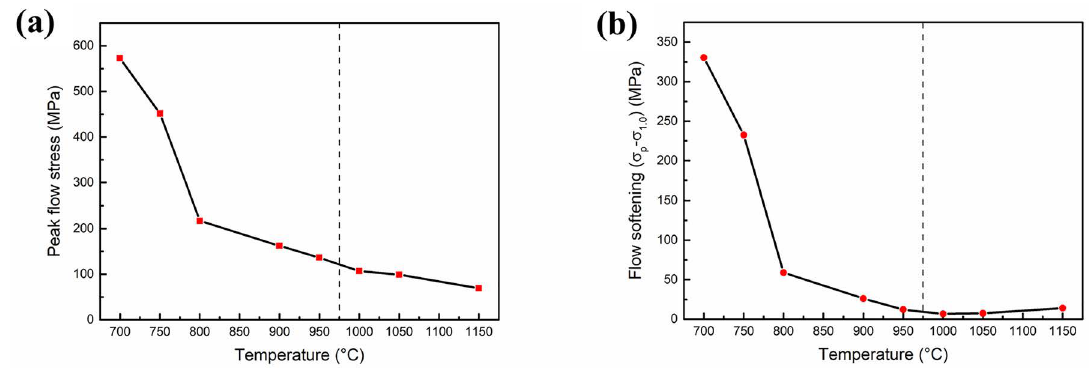
Figure 3. The changing of peak flow stress and flow softening values of as-consolidated PM Ti-5553 alloy with temperature of during hot deformation: (a) peak flow stress; and (b) flow softening (σ